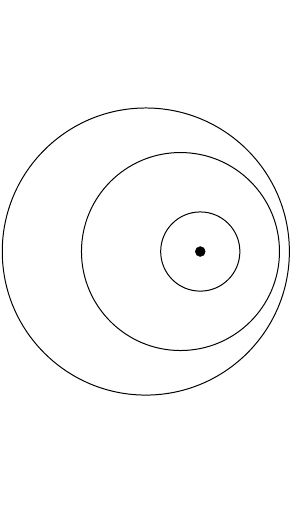
Figure 1: Decomposition of S 3 into Hopf tori and two circles.